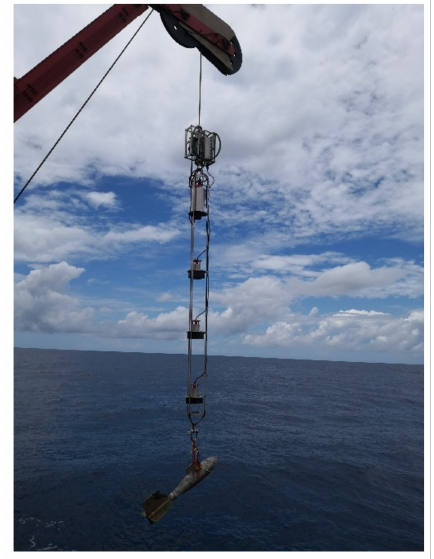
Figure 4. Linear